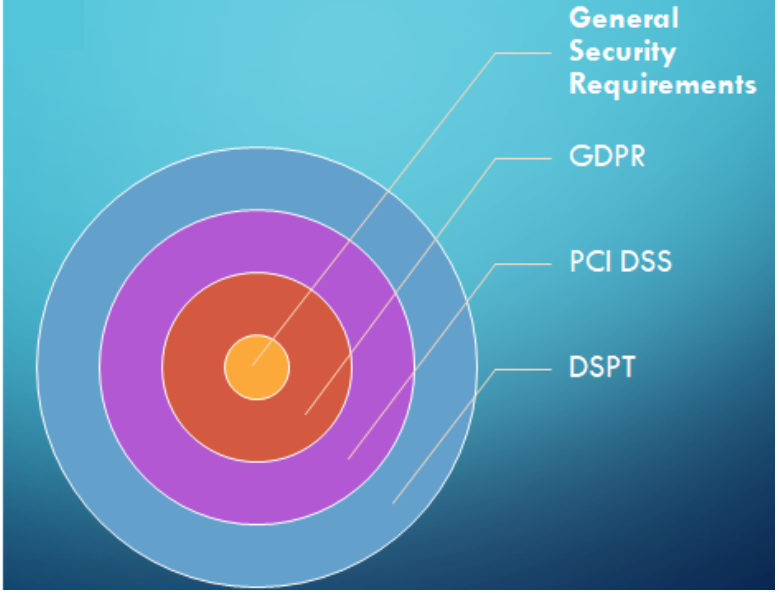
Figure 6. Merging of different requirements into the proposed